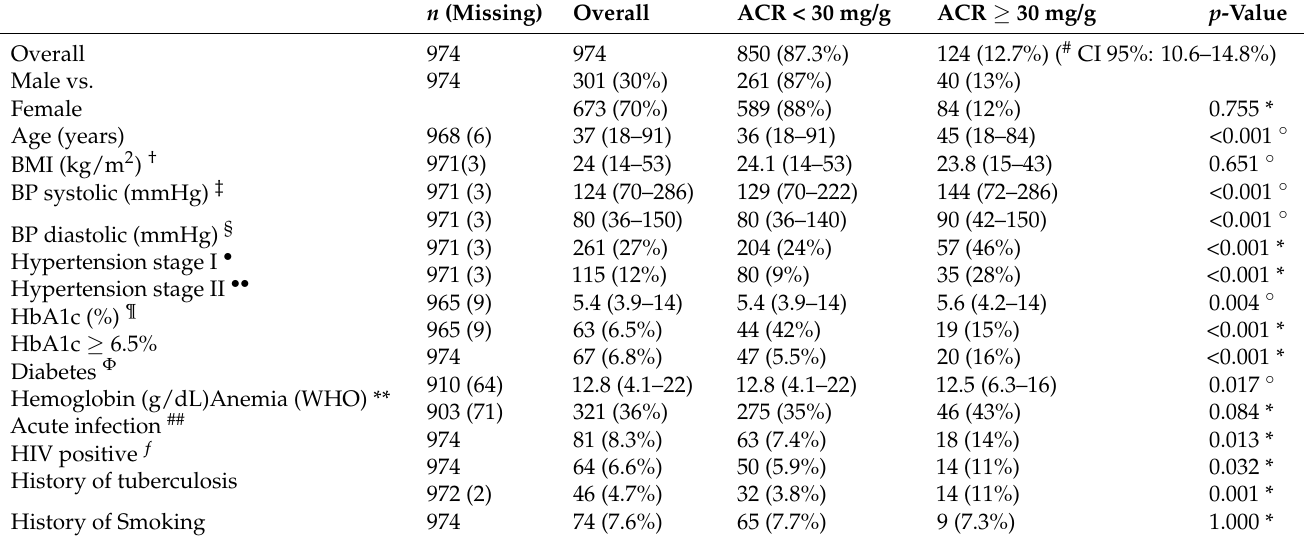
Table 1. Patient